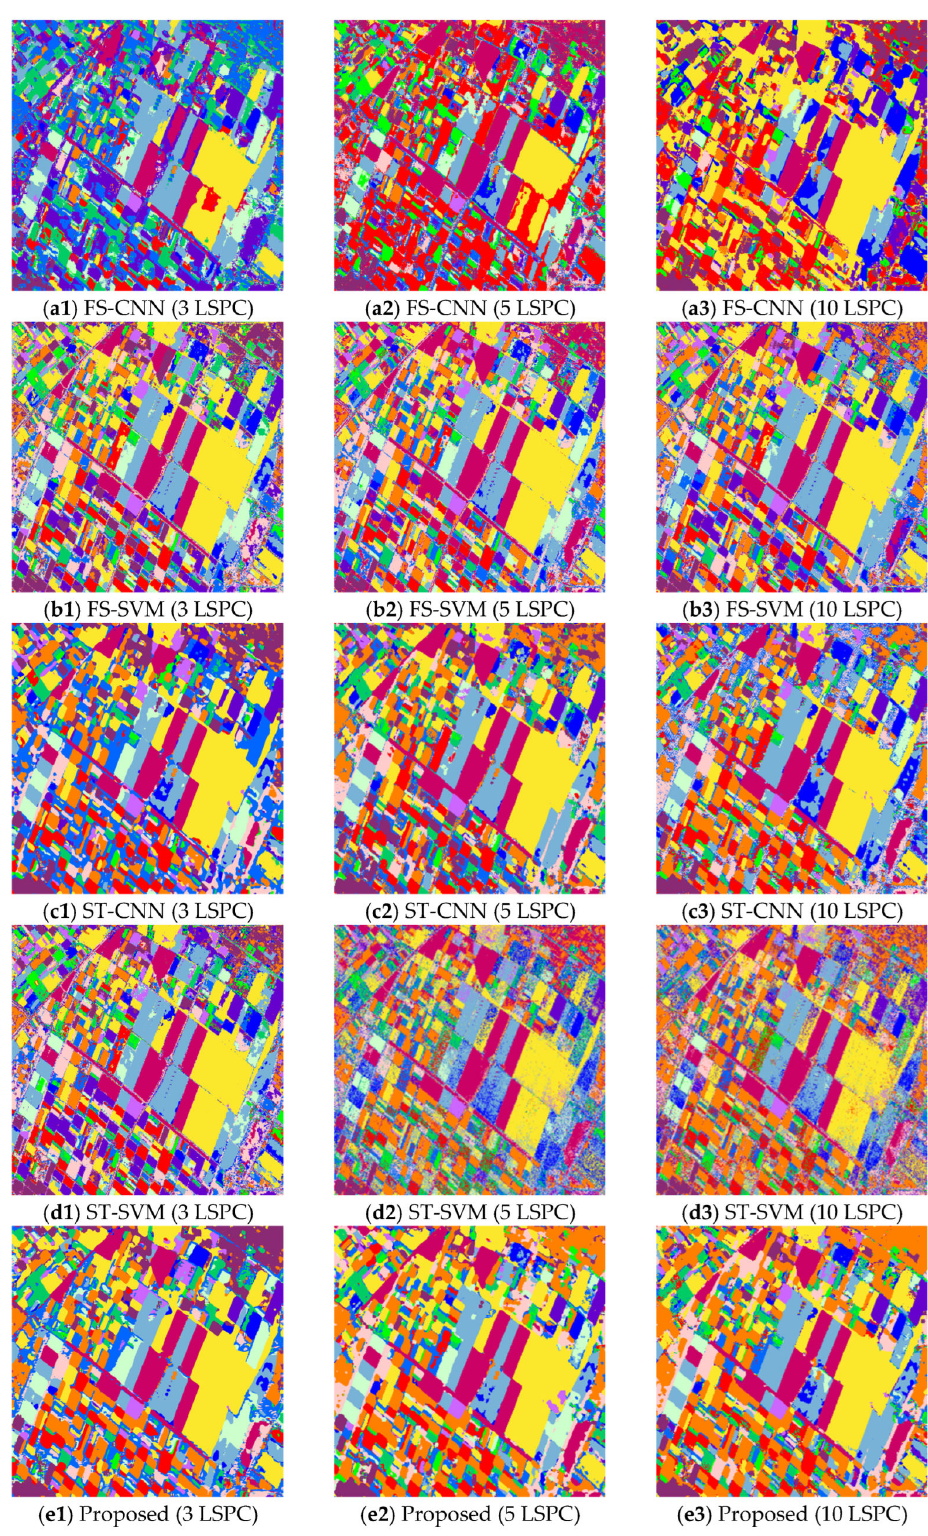
Figure 9. Classification maps of dataset 2 given by the five methods with different sample sizes. The maps from up to down are given by FS-CNN, FS-SVM, ST-CNN, ST-SVM and the proposed methods, respectively, and those from left to right have 3, 5, and 10 LSPCs,